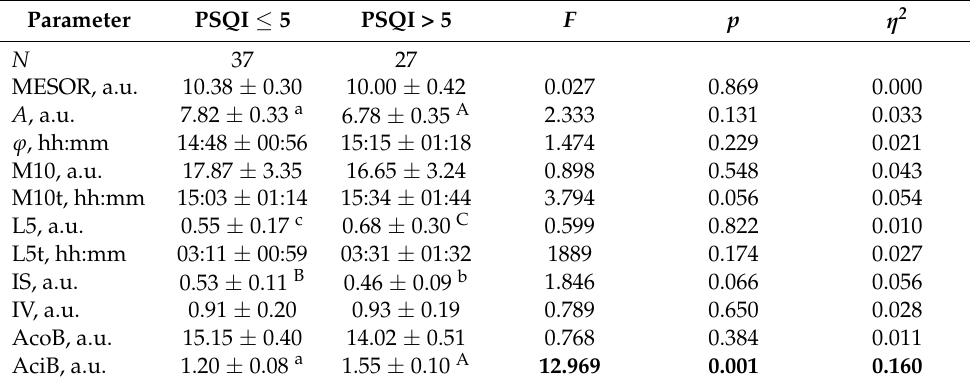
Abbreviations as in Table 1. For details see footnote to Table 2. Table 5. Association of sleep quality with 24 h rest–activity rhythm characteristics.